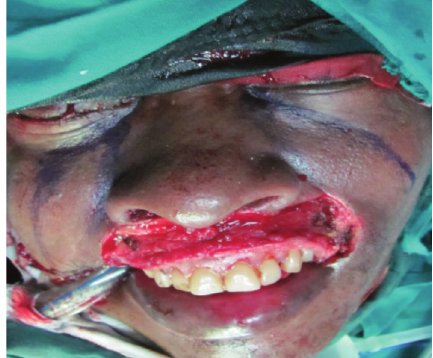
Figure 2: Postexcision of the tumor and marking for nasolabial flaps.